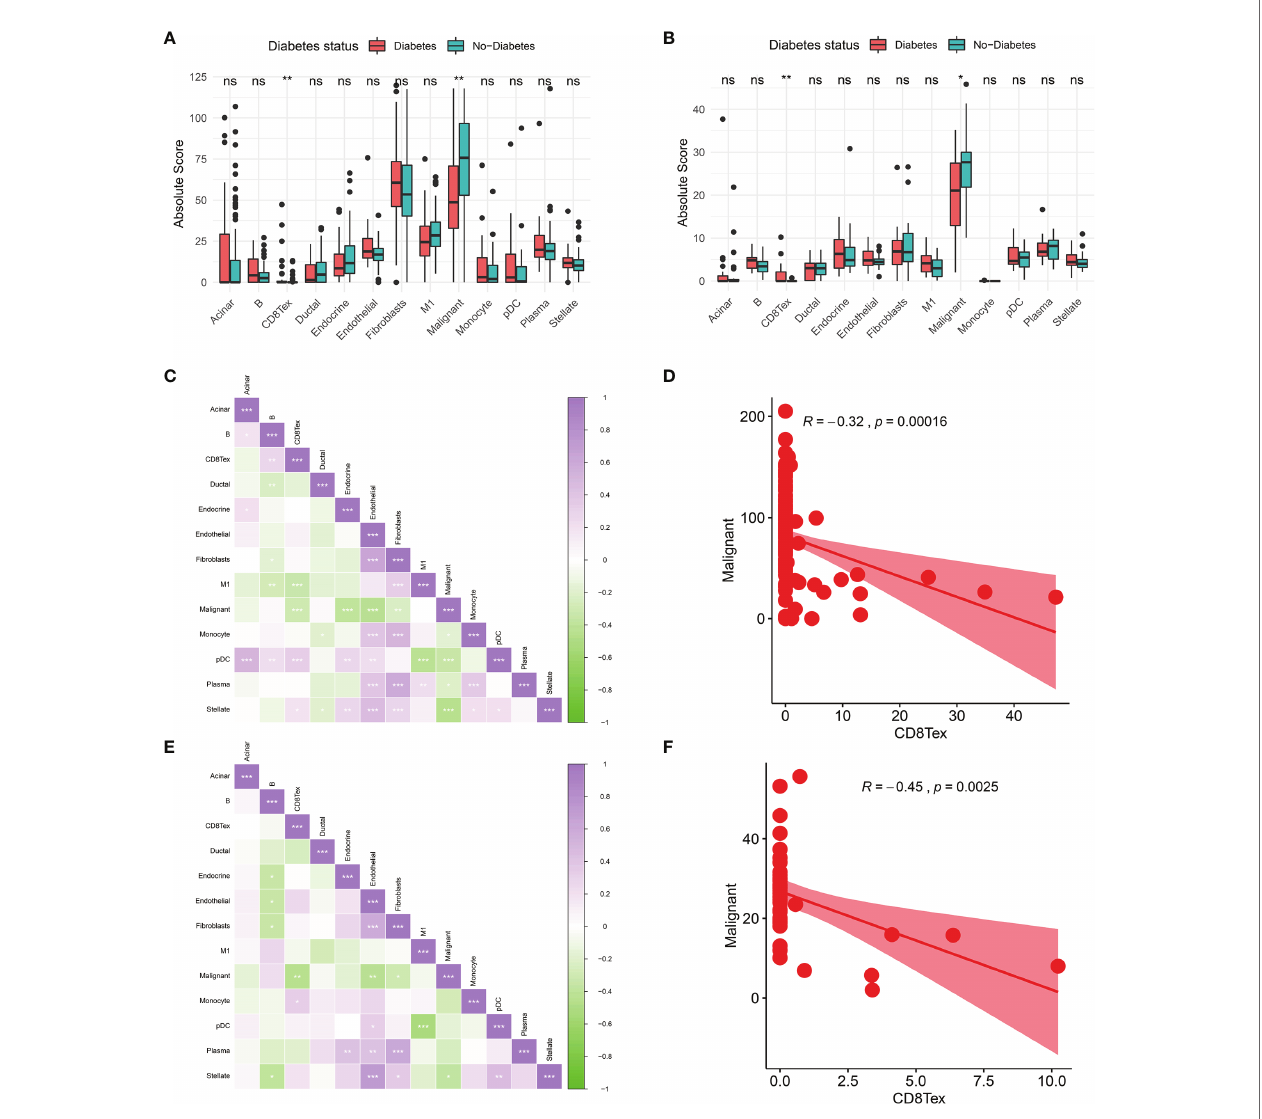
FIGURE 4 | Comparison of the tumor immune microenvironment in patients with diabetic pancreatic cancer versus non-diabetic pancreatic cancer. (A) Mean value test of Absolute Score of tumor tissues of 13 cells in the TCGA PAAD dataset. (B) Mean value test (wilcox-test) of Absolute Score of tumour tissue from 13 cells in the GSE79668 dataset. (C) Correlation of Absolute scores of 13 cell types in the TCGA PAAD dataset. (D) Correlation of Malignant and CD8Tex in the TCGA PAAD dataset. (E) Correlation of Absolute scores of 13 cell species in the GSE79668 dataset. (F) Correlation between Malignant and CD8Tex in the GSE79668 dataset. (Spearman correlation test). ns, Not Signi fi cant, *p < 0.05, **p < 0.01, ***p <